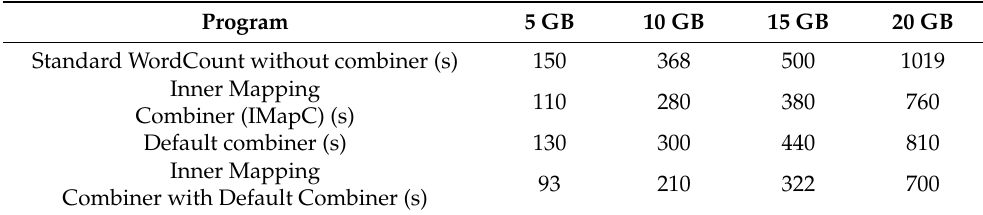
Table 4. Performance improvement of IMapC with Default Combiner on running WordCount program in